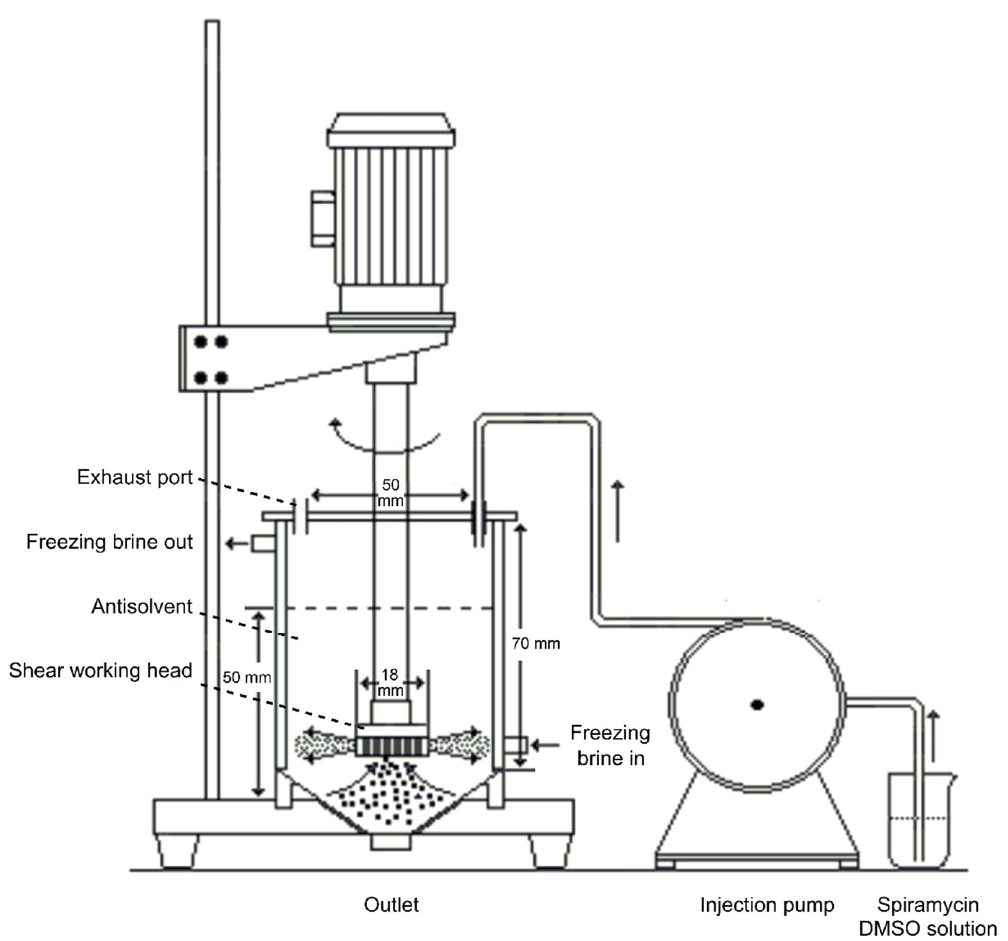
Figure 2. Schematic drawing of homogenate ‐ antisolvent precipitation apparatus to prepare the micronized spiramycin.